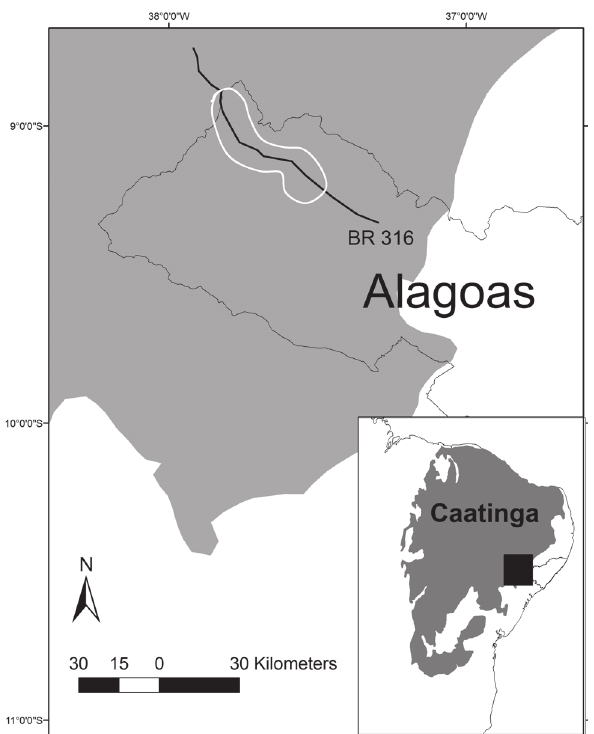
Figure 1. Location of the study area. BR 316 (black line) and sampled area (white line) are detached.